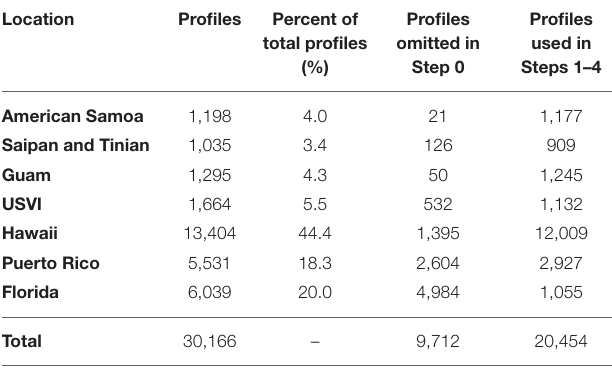
TABLE 1 | Spatial distribution of coral reef topobathymetric cross-shore profiles included in the initial dataset, as well as the number of profiles from each location included in the